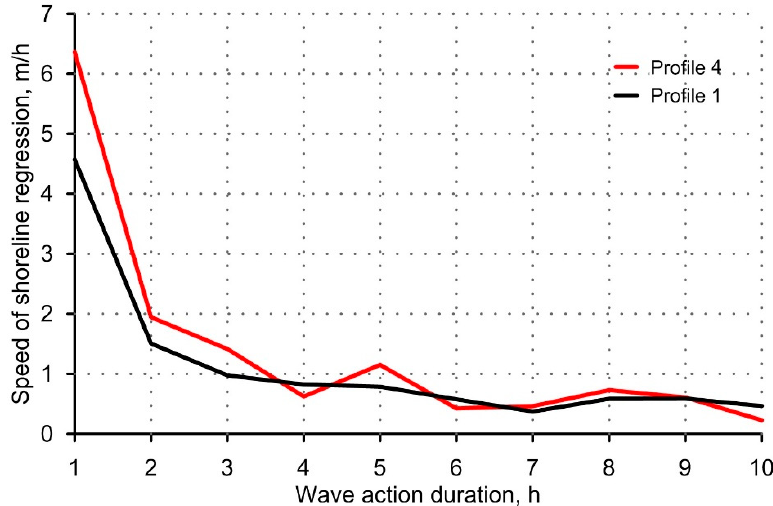
Figure 6. The speed of shoreline regression (m/h) variations during the numerical experiment that was run on profiles 1 (black) and 4 (red).